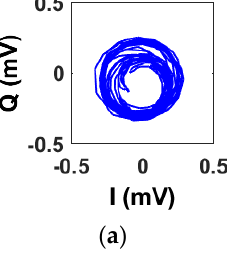
Figure 8. Example of baseband signals in the IQ plane obtained with the mmWave radar after applying the DC calibration methods. ( a ) Original signal. ( b ) AC coupling. ( c ) Algebraic distance. ( d ) Geometric distance.